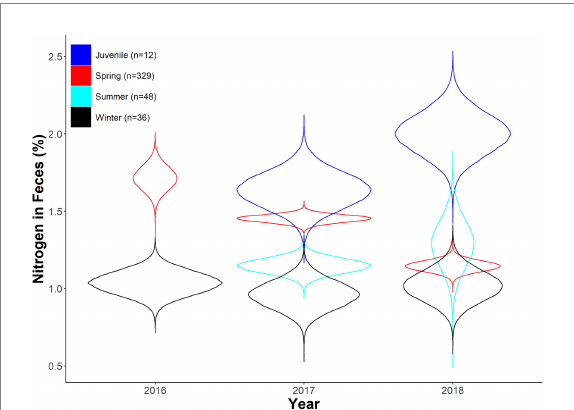
FIGURE 2 Expected fecal nitrogen percent as a function of year and season for desert bighorn sheep at Lone Mountain, Nevada (2016–2018). Violin plots represent the posterior distributions for predicted mean values derived from an ANOVA model of fecal nitrogen modeled as a function of year and season (with interaction term), which was fitted in a Bayesian framework ( n =